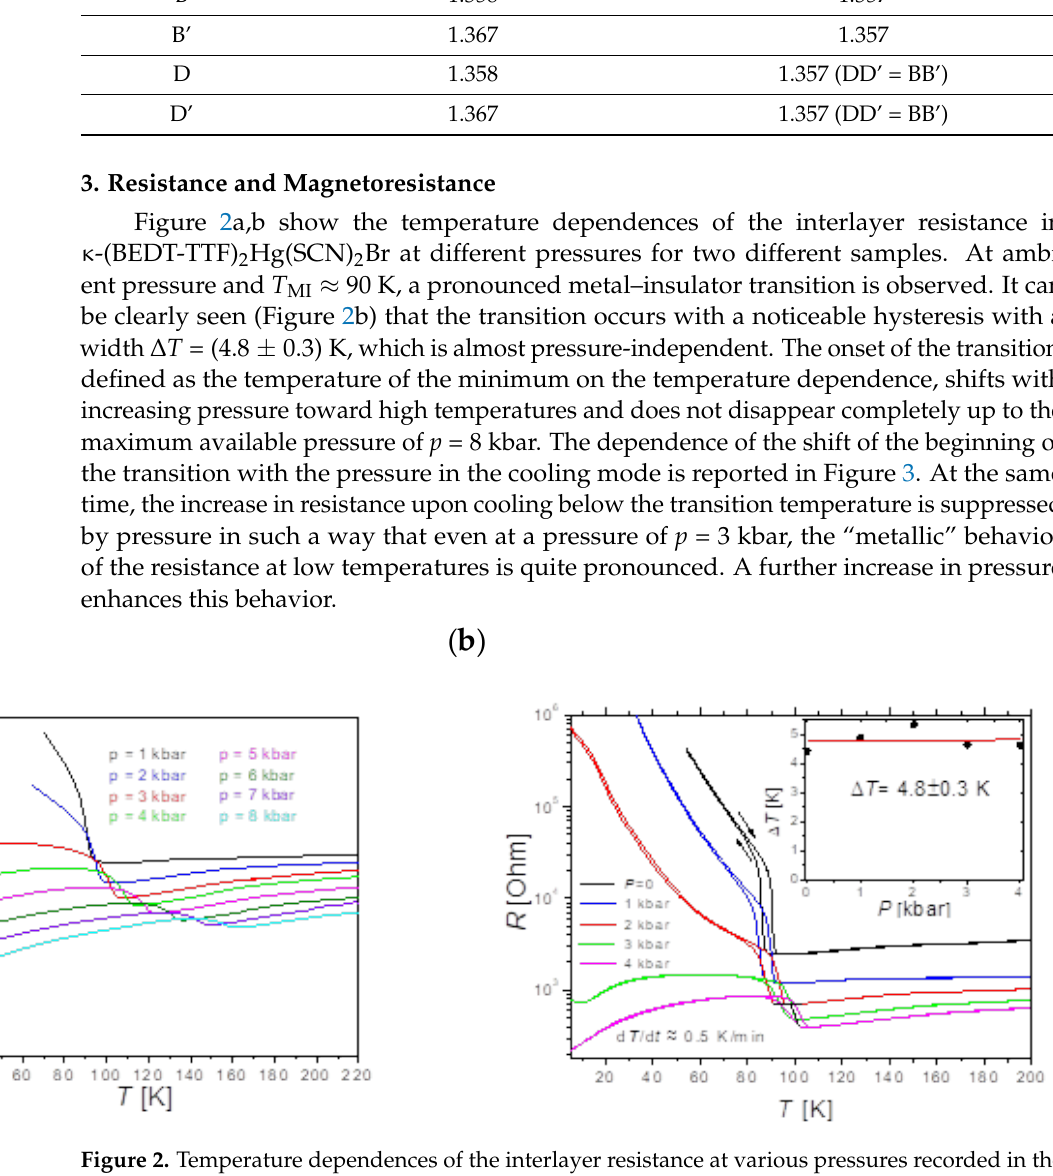
Table 1. Central C = C bond lengths for the different BEDT-TTF donors in the low- and high- temperature structures of κ -(BEDT-TTF) 2 Hg(SCN) 2 Br (in Å) (see Figure 1b for the labeling). Donor Molecule Low-Temperature Structure (80 K) High-Temperature Structure (150 K) A 1.357 1.357 A’ C